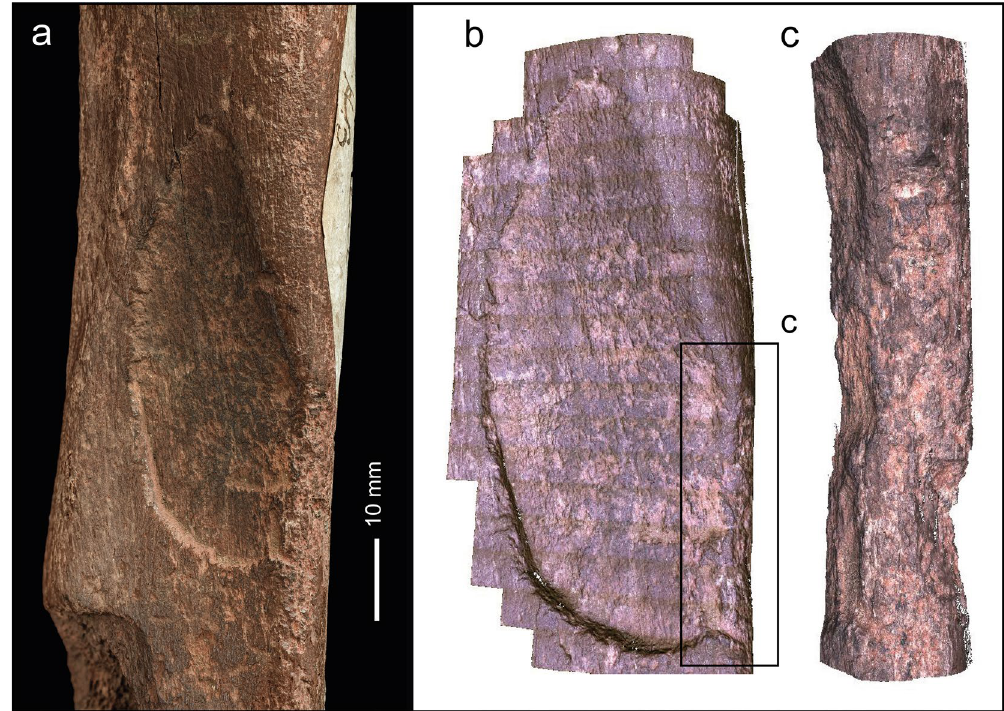
Figure 6. NHMUK PV M 103081—Photograph ( a ) and Alicona images ( b , c ) of flake scar and associated battering in a depression created by attrition near the distal end of the shaft. Note the contrast between the area with extensive pitting in the depression along the outer cortical surface and the surrounding unmodified/ corroded